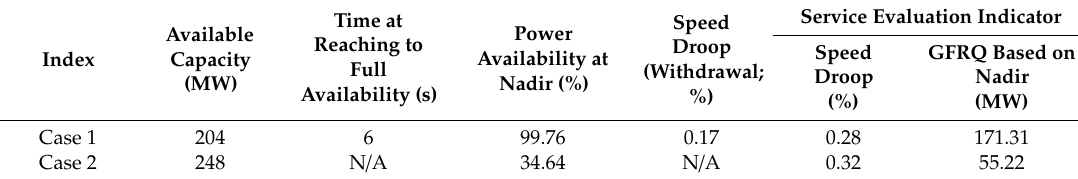
Table 9. Evaluation results of on-site responses from Figures 13 and